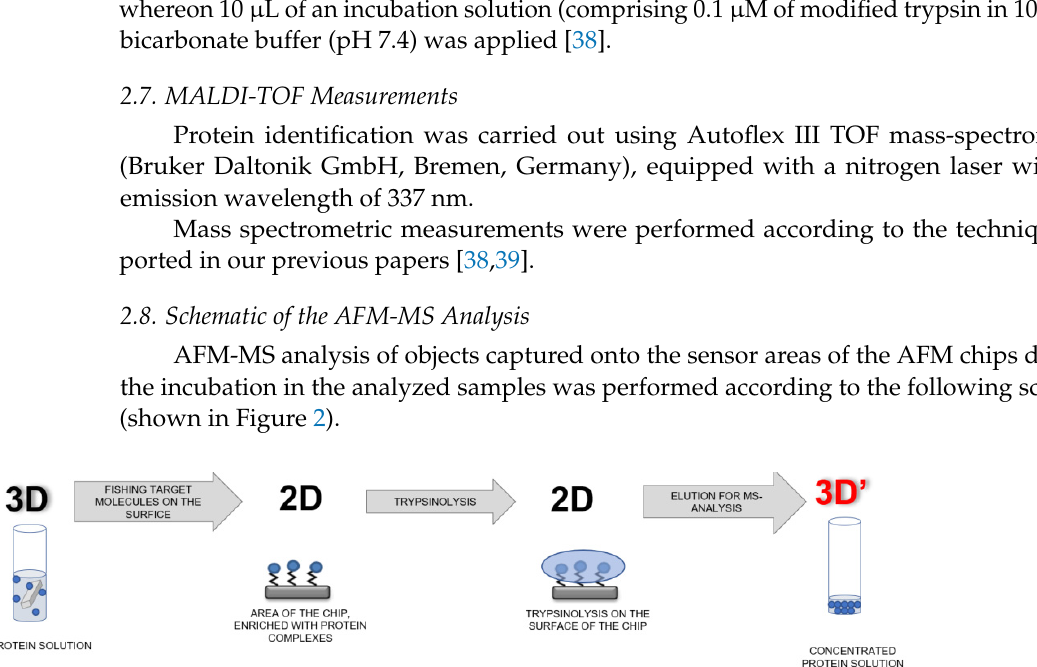
Figure 2. Schematic representation of mass spectrometric analysis of protein complexes concentrated on the surface of AFM chips.